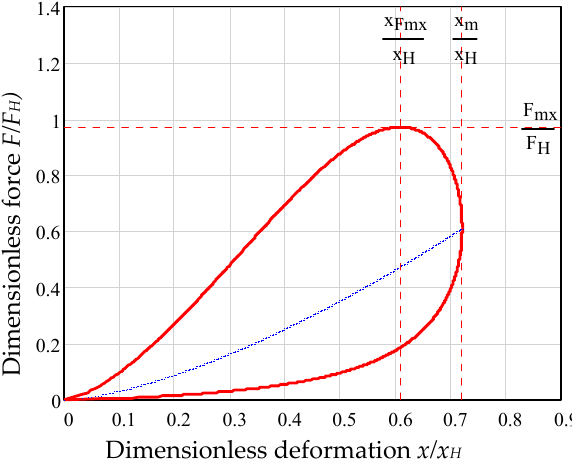
Figure 6. Hysteresis loop.